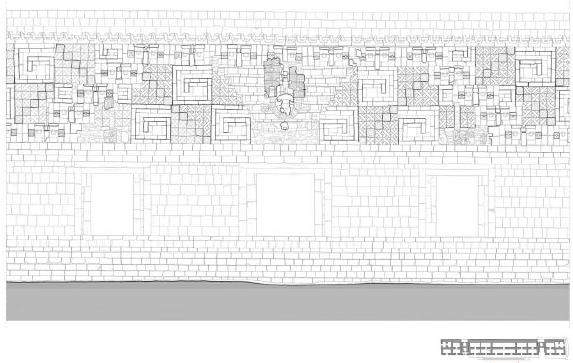
Figure 16. Digital architectonic drawing of the Palace of the Governor’s front facade central elevation. (Project MAYATECH 2019).